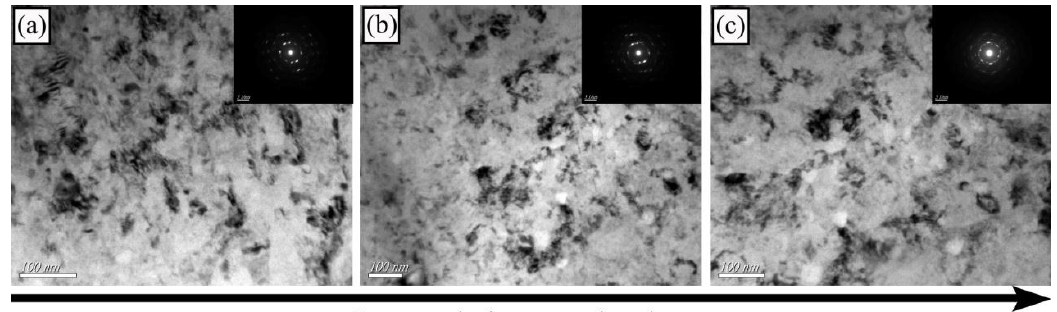
Figure 4. TEM images of nano-grains at the top surface and the inset showing the corresponding SAED patterns. ( a ) 3 LSP impacts; ( b ) 5 LSP impacts; ( c ) 10 LSP impacts.